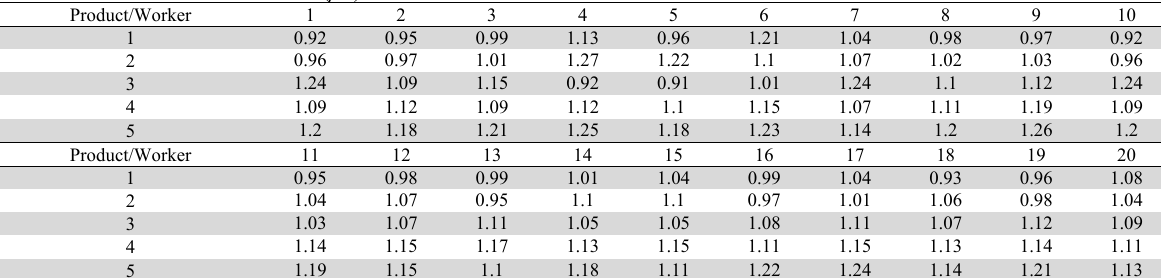
Table 2 The data of worker’s level of skill ( β ni ) Product/Worker